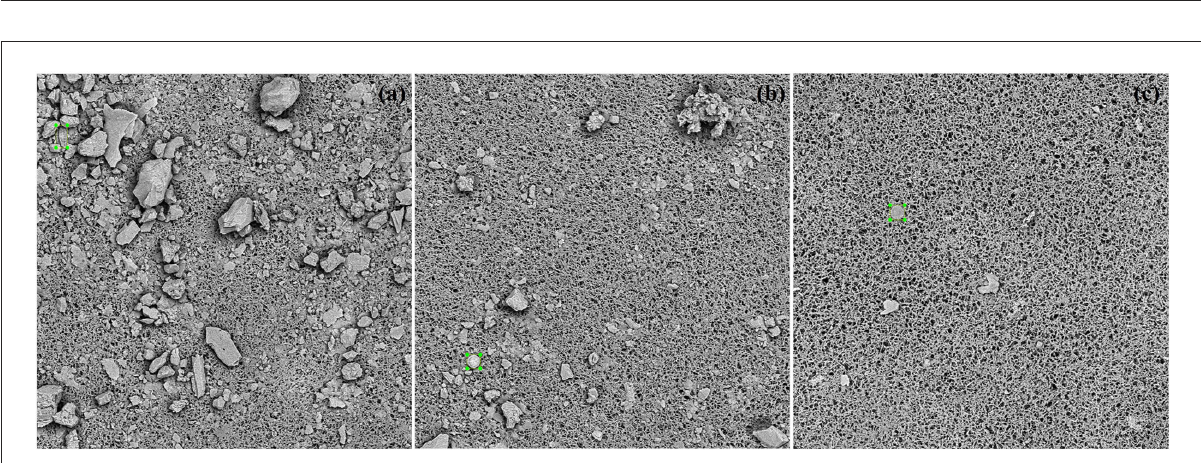
we notice that the precision and the recall get closed at a low confidence threshold of 0.1 for the RetinaNet-101-Last-800 model, while the YOLOv5m-Last-800 model approaches the